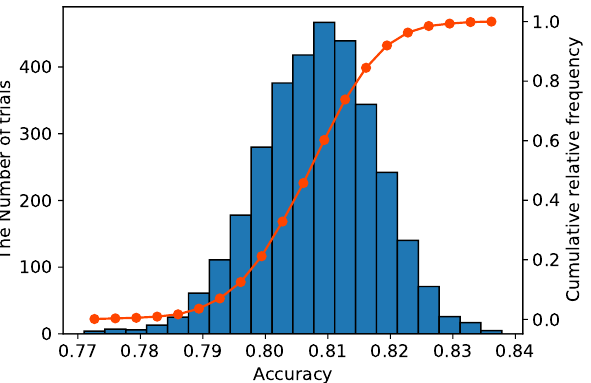
Figure 5. Distribution of accuracy when attempting all possible patterns of class hierarchy in the HASC